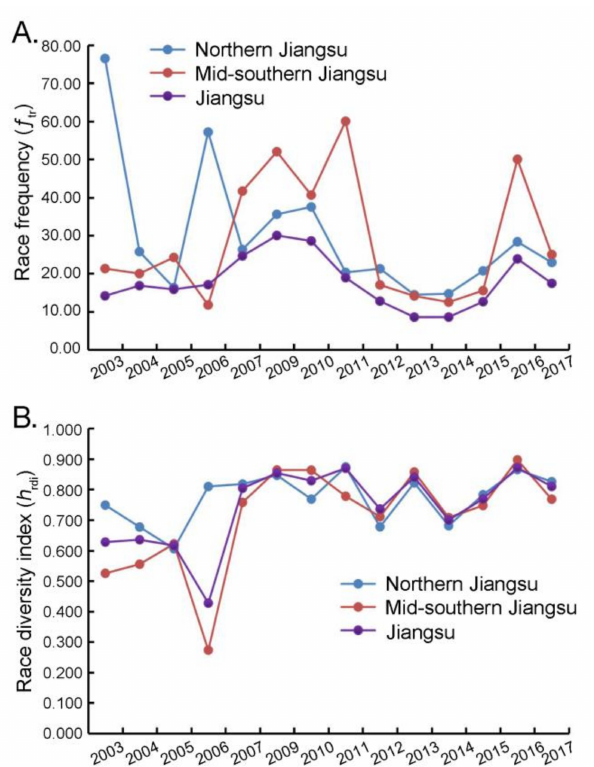
Figure 1. The race frequency and race diversity index of the P. oryzae in different regions of Jiangsu province from 2003 to 2017. The race frequency ( A ). The race diversity index ( B ). The blue line represents P. oryzae from Northern Jiangsu; the red line represents P. oryzae from mid-southern Jiangsu and the purple line represents P. oryzae from Jiangsu.